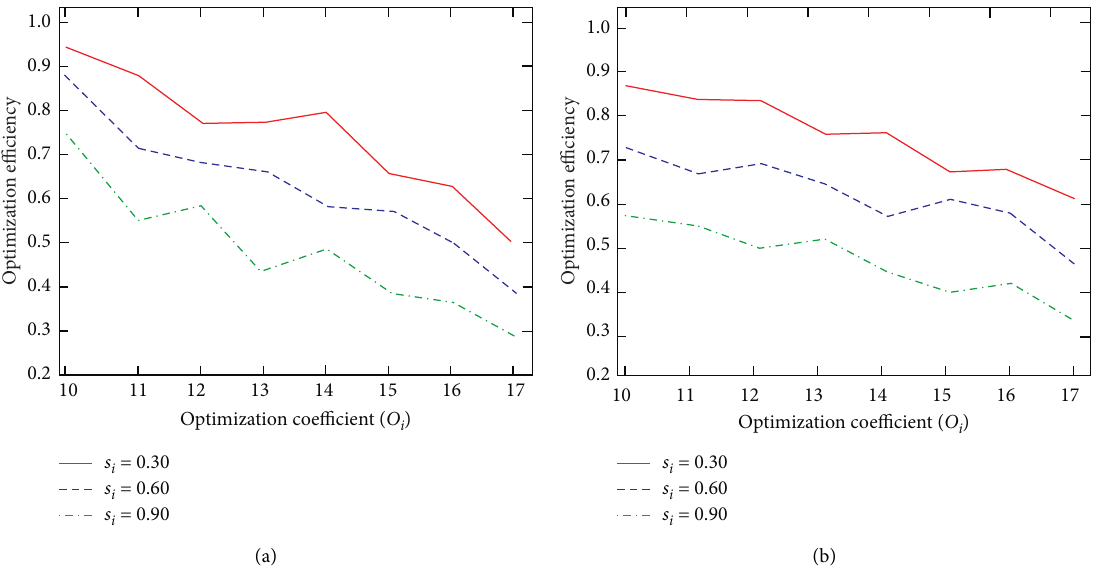
Figure 5: Relationship between optimization efficiency and coefficient with different weighting factors ( s management model.